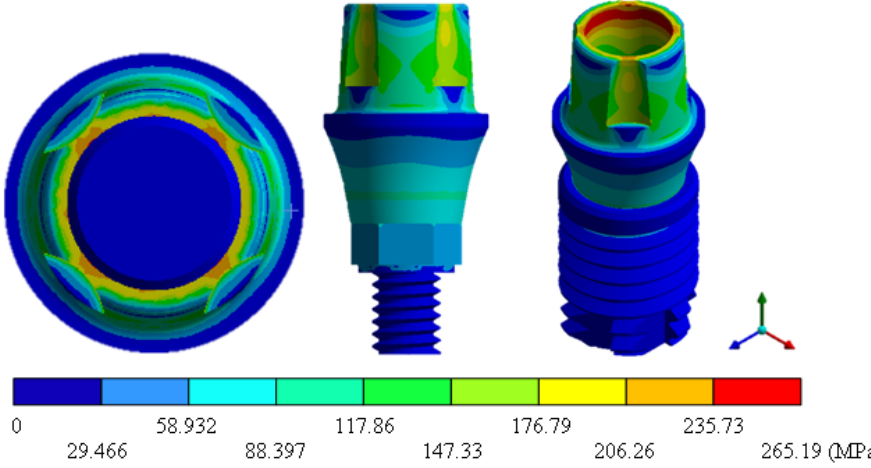
Figure 18. Von Mises stress for Snappy-type implant (ZrO 2 ).